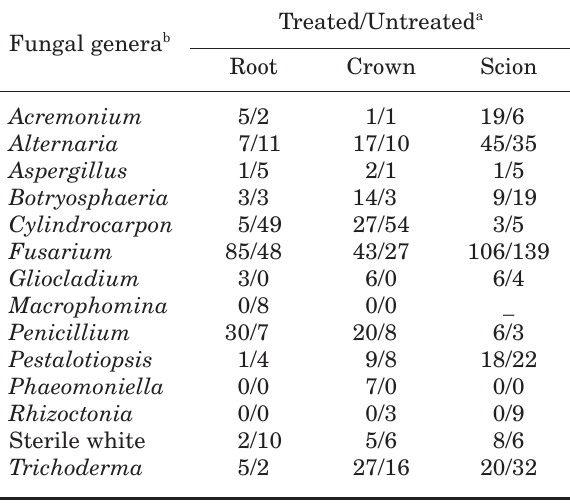
Table 1. Endophytic fungi most frequently isolated from grapevine root, crown and scion areas 6 months after being planted out in the field. The figures indicate the total number of isolations from a given cutting region; e.g. 5/2 indicates 5 Acremonium isolates from roots of hot-water treated, and 2 isolates from untreated cut- tings. Only those fungi that had an occurrence of more than 1% have been